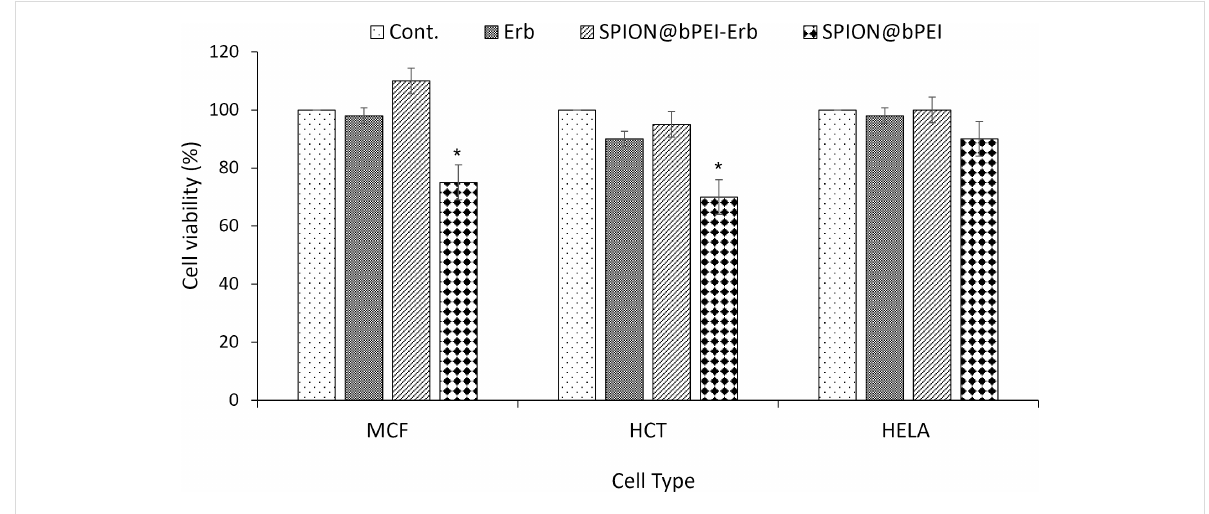
Figure 5: MTT cytotoxicity assay in MCF7, HCT116, and HeLa cells treated with free Erb (0.62 μ g/mL), SPION@bPEI (19.2 μ g/mL), and SPION@bPEI-Erb (20.7 μ g/mL). The results are expressed as the mean of three independent experiments ± standard error and subjected to one-way ANOVA with Tukey's